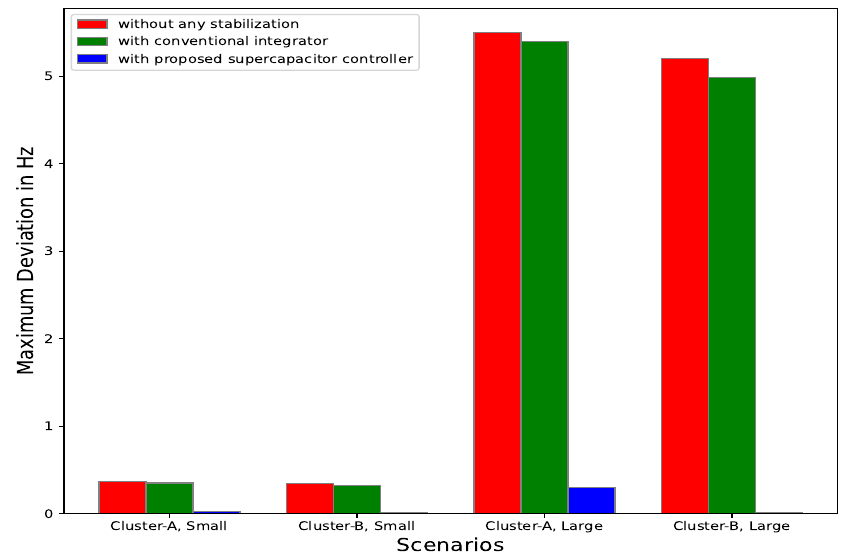
Figure 10. Frequency response for all disturbance scenarios applied in cluster A.